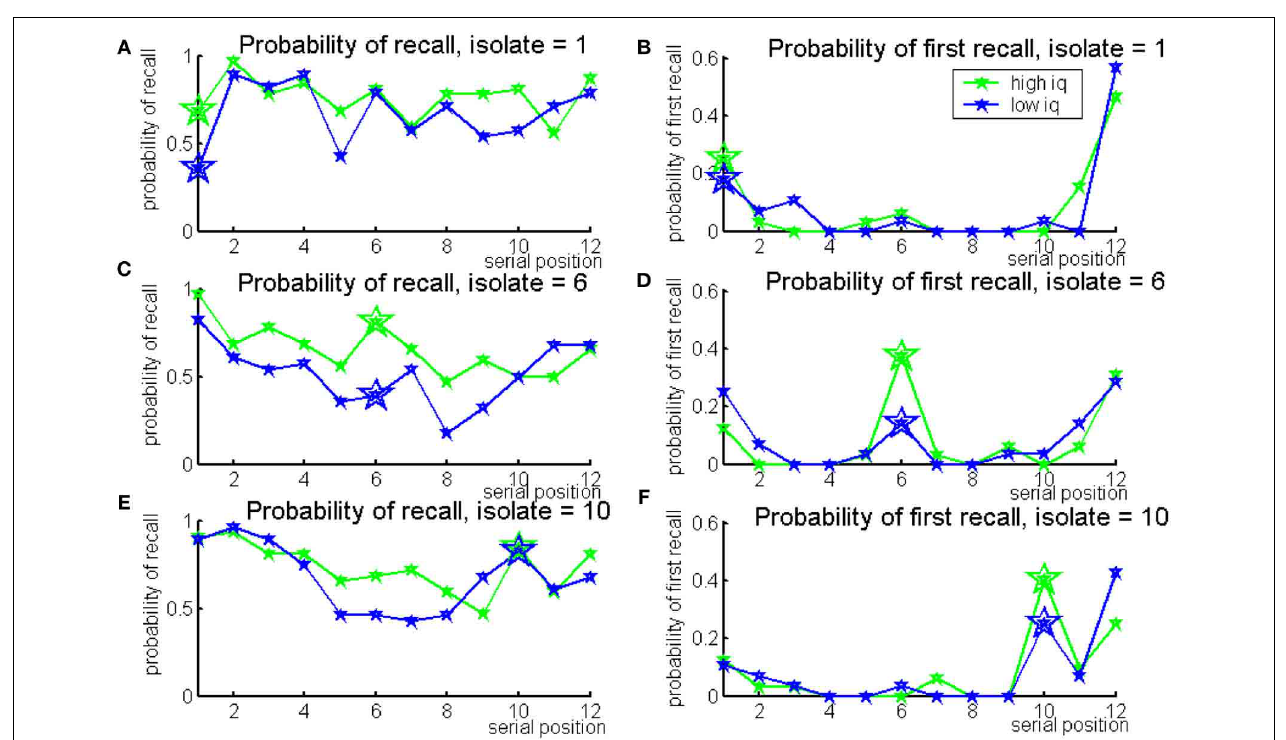
FIGURE 2 | Probabilities of recall (left panels) and first recall (right panels), for the Von Restorff lists by the isolate serial position in the list, split by IQ median score (green for higher-IQ individuals, blue for lower-IQ